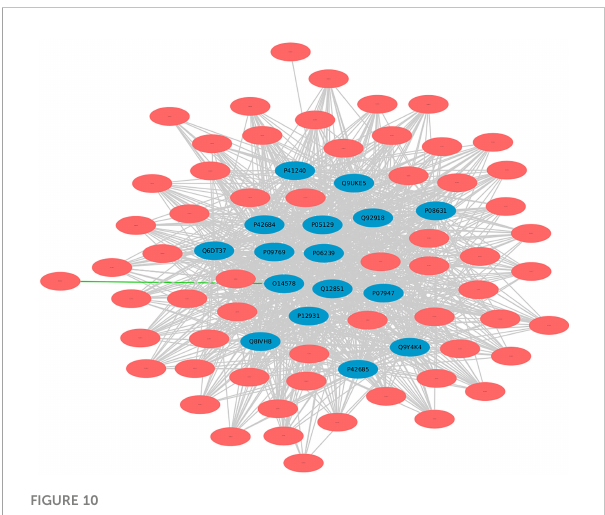
FIGURE 10 Human targets for the drug “ Fostamatinib ” . Blue nodes represent host proteins, and red nodes are pathogen proteins. Green edges depict the interactions from interolog-based approach, while grey edges belong to domain-based